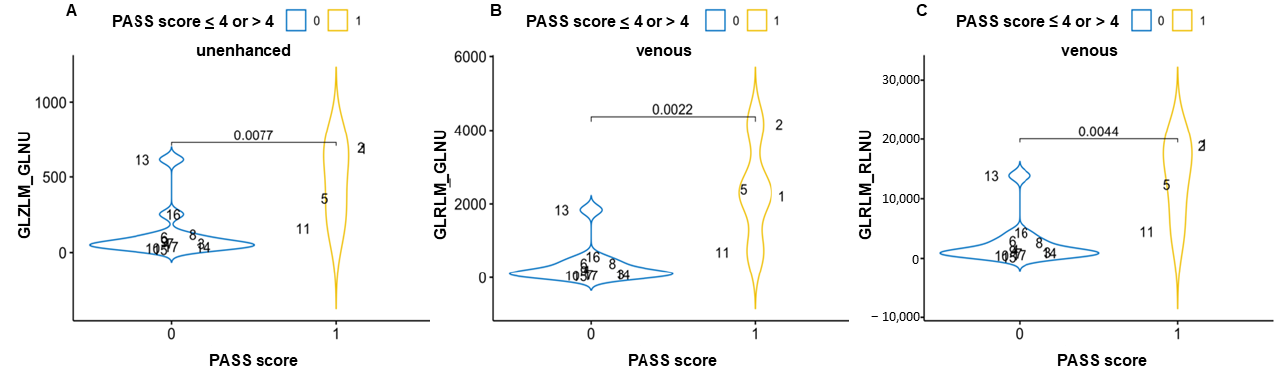
Figure 3. Violin plots showing the statistically significant differences in textural parameters between pheochromocytomas with PASS score ≤ 4 or >4 in an unenhanced scan ( A ) and venous scans ( B , C ). GLZLM_GLNU = gray-level zone-length matrix–gray-level non-uniformity; GLRLM_GLNU = gray-level run-length matrix–gray level non-uniformity; GLRLM_RLNU = gray-level run-length matrix–run-length non-uniformity.